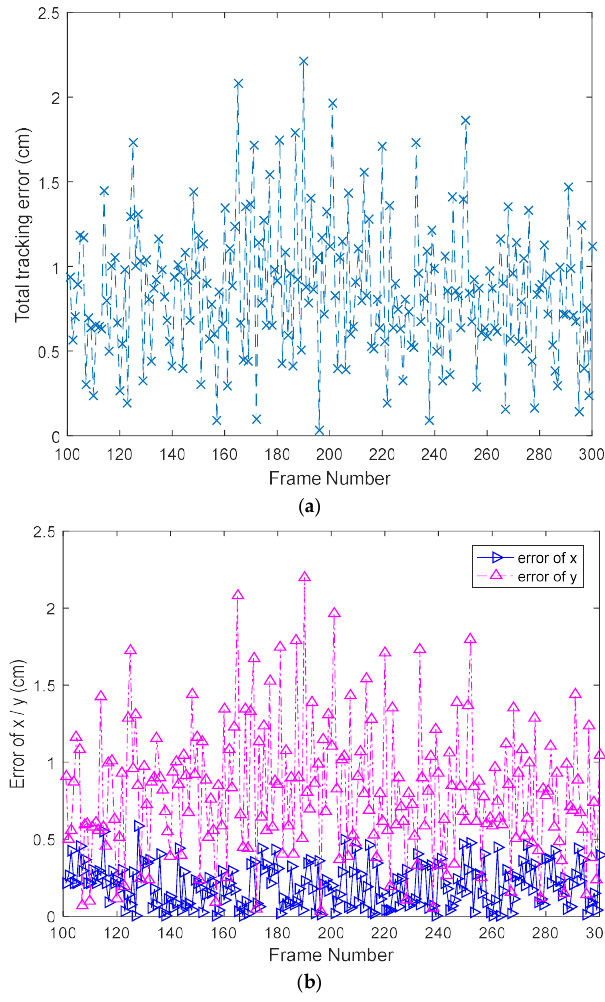
Figure 9. Tracking error of the target signal source LED: ( a ) total tracking error, and ( b ) tracking error of x and y